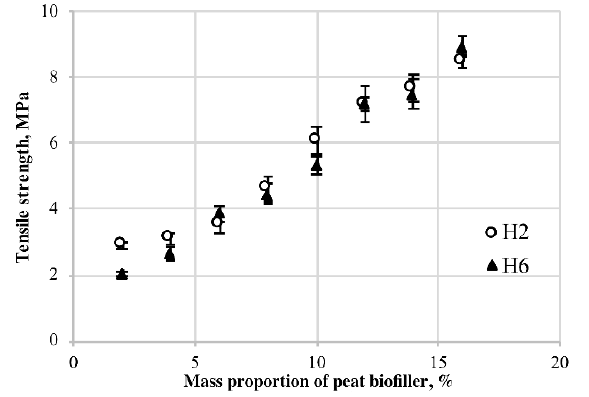
Figure 7. Tensile strength as a function of the mass proportion of biomass in polyurethane.